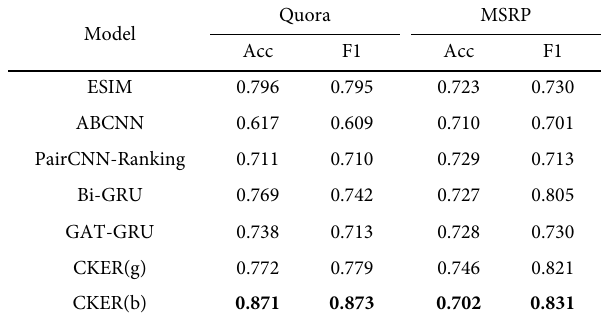
Table 3 Performance in Quora and MSRP. CKER(g) uses GRU as the Sentence Encoder. CKER(b) uses BERT as the Sentence Encoder. Acc represents